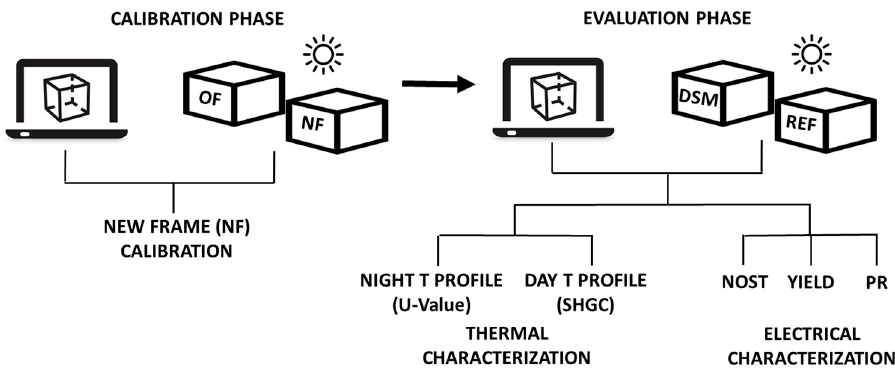
Figure 3. Sketch of the method used for the DSM characterization.